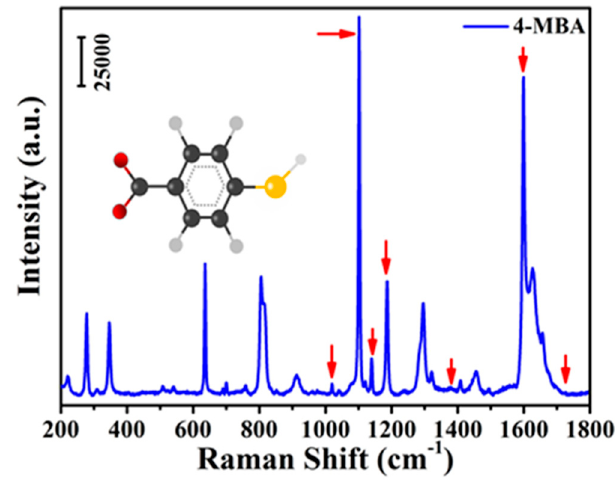
Chemosensors 2021 , 9 , x FOR PEER REVIEW Figure 4. Raman spectra of 4-MBA powder under 633 nm excitation. Figure 4. Raman spectra of 4-MBA powder under 633 nm excitation.